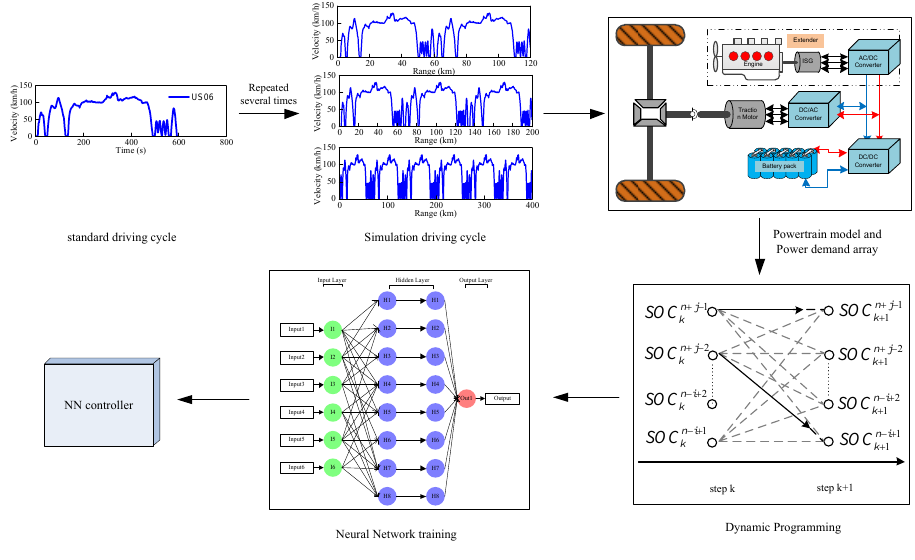
Figure 5. NN controller design